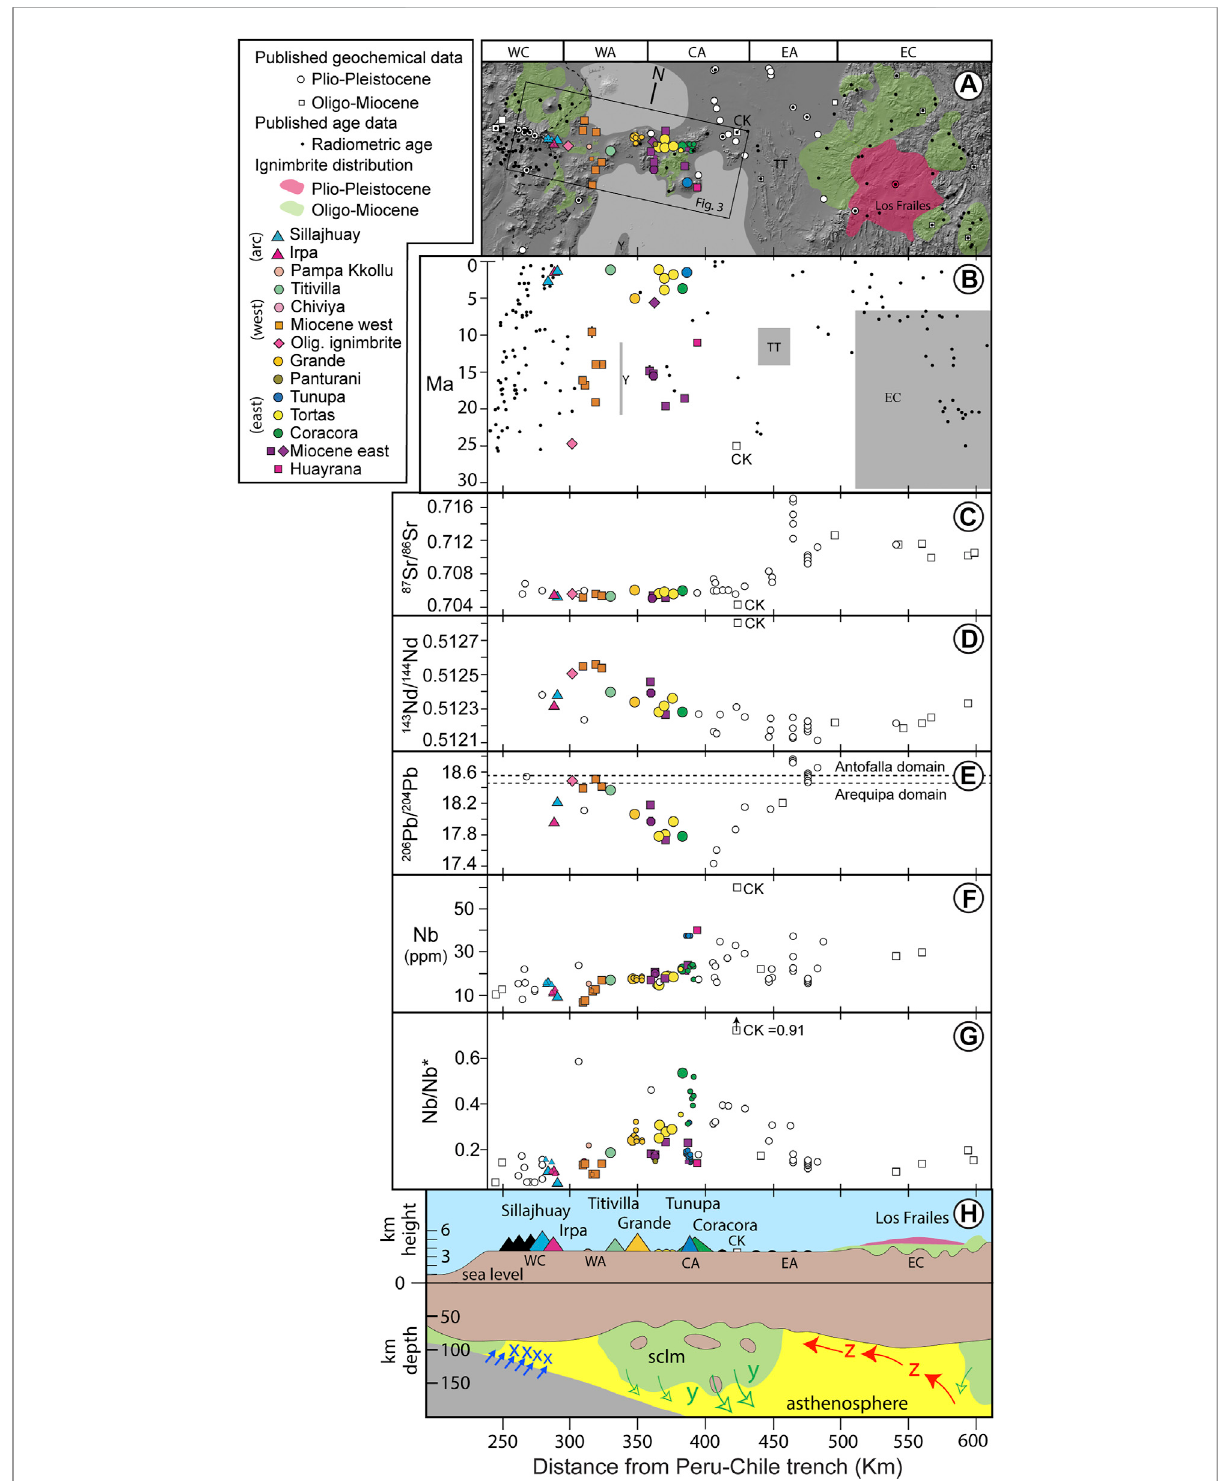
FIGURE 13 Arc-perpendicular compilation of available data collected within the larger bounding box of Figure 1. Note that north is offset approximately 12.5 ° to align perpendicular to the Peru-Chile trench and the trend of the CVZ arc (See Figure 1). Colored symbols from this study and Salisbury et al. (2015); larger symbols indicate samples with 49 Ar/ 39 Ar age data. Compositional data are restricted to < 66 wt% SiO 2 . (A) Sample localities of this study and all available published data within the con fi nes of the image. The horizontal axis is shown in (H) and is the same in all graphs. WC, Western